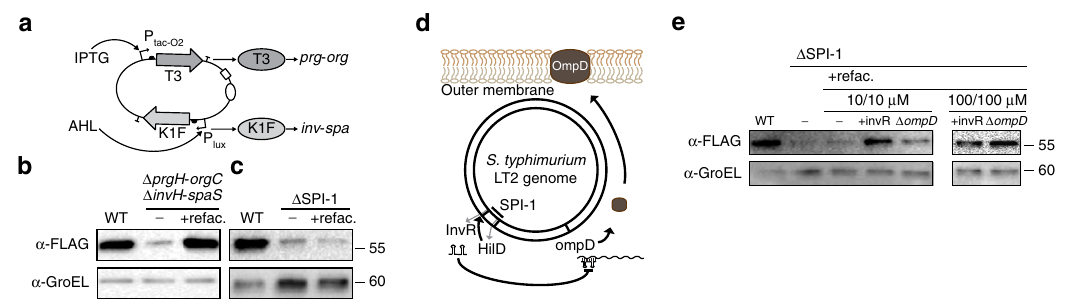
Figure 3 | Completion of the refactored SPI-1. ( a ) The dual controller is shown where T7*(T3) and T7*(K1F) are under IPTG- and AHL-inducible control, respectively (Supplementary Fig. 17). ( b ) A secretion assay is shown for a double knockout strain containing the two refactored operons ( prg - org R4 and inv - spa R3 ) with a controller ( þ 10 m M IPTG/ þ 10 m M AHL). The – lane is the absence of any complementation plasmid but with the inclusion of the reporter. ( c ) The secretion assay is shown for the duel ( prg - org R4 and inv - spa R3 ) and controller ( þ 10 m M IPTG/ þ 10 m M AHL) in D SPI-1 strain. ( d ) An illustration of the repression of major Salmonella porin protein OmpD by small regulatory RNA, InvR upon activation by HilD encoded in SPI-1 (refs 1–3). ( e ) The secretion assay in a D SPI-1 background complemented with the refactored operons ( prg - org R4 and inv - spa R3 ; lane 3) and controller ( þ 10 m M IPTG/ þ 10 m M AHL). The þ invR lane corresponds to the presence of the small RNA ( prg - org R5 and inv - spa R4 , MR27). The D ompD strain contains the additional porin